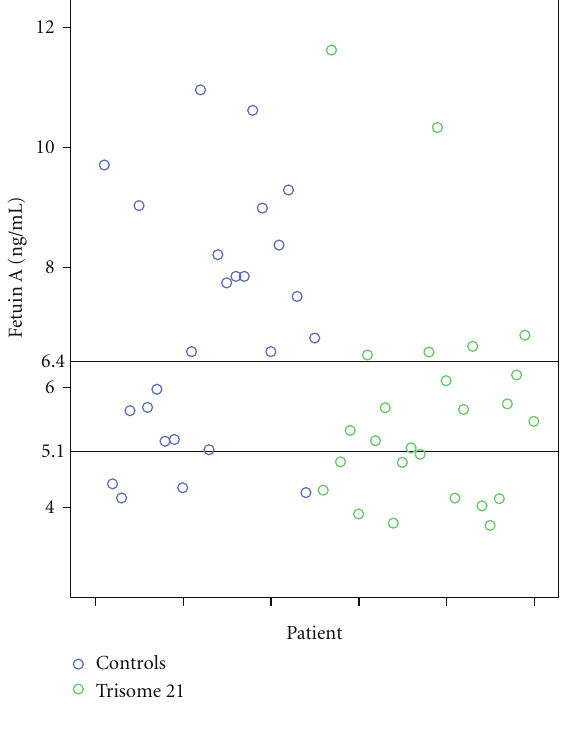
Figure 1: Scatter-plot graph of fetuin A concentrations (ng/mL) in normal fetuses and fetuses with trisomy